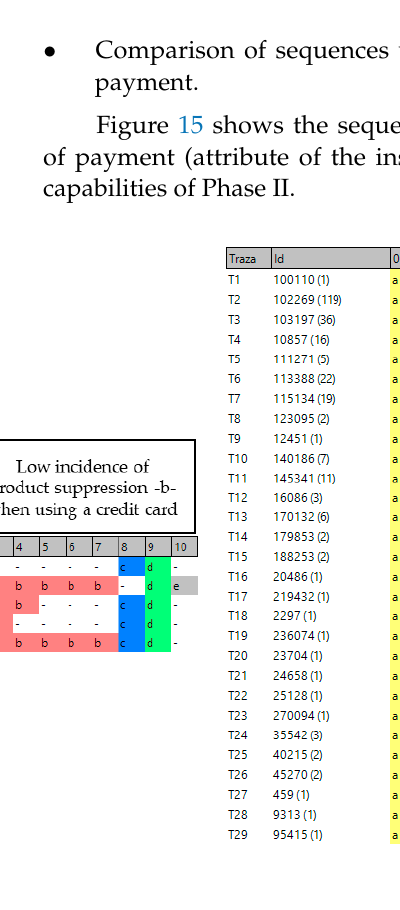
Figure 15. Sequences with product deletions: ( a ) using credit cards; ( b ) using cash.